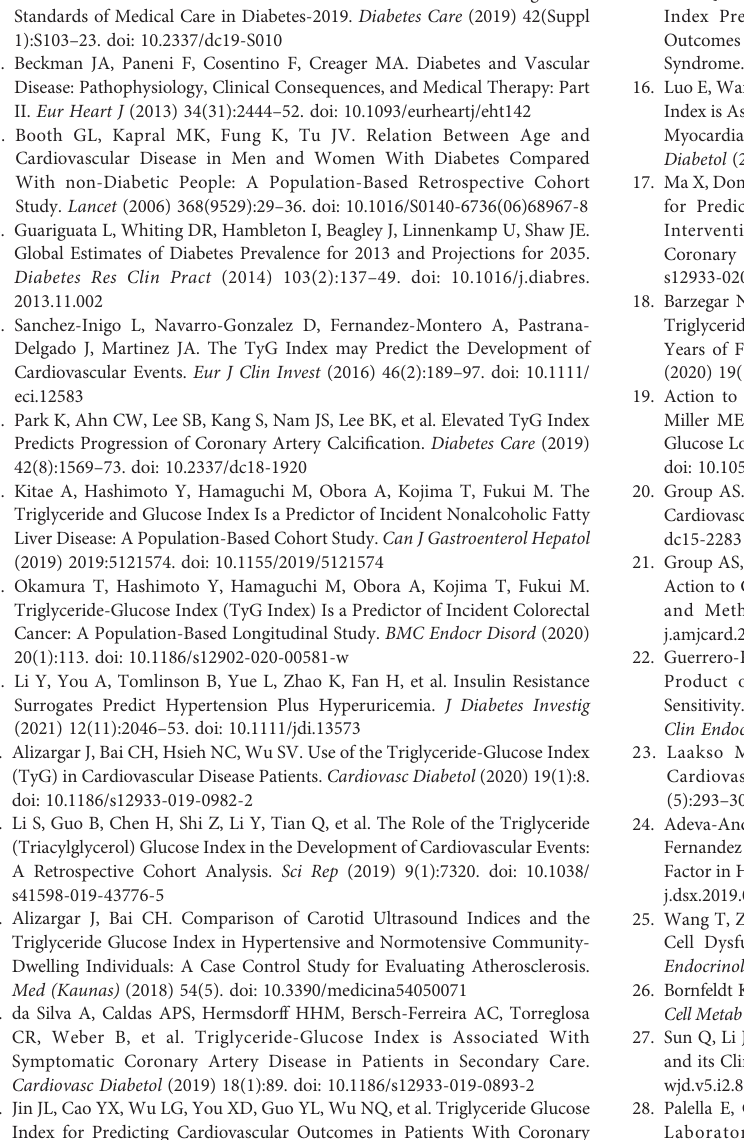
Supplementary Table 1 | Group-based trajectory model fi t summary (N=9,697). Supplementary Table 2 | Risk of incident secondary outcomes for baseline TyG index. Model 1: Adjusted for baseline age, sex, previous cardiovascular event, race,